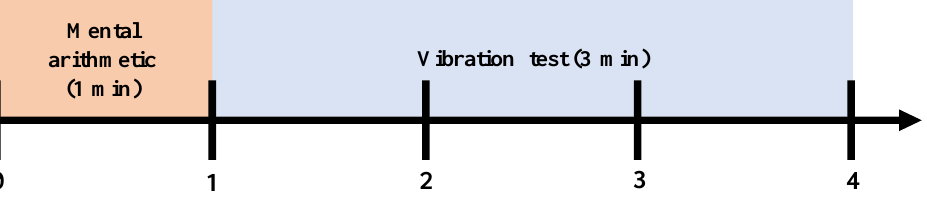
T i m e [ m i n ] Figure 8. Flow of the experiments. Figure 8. Flow of the experiments. Figure 8. Flow of the experiments.